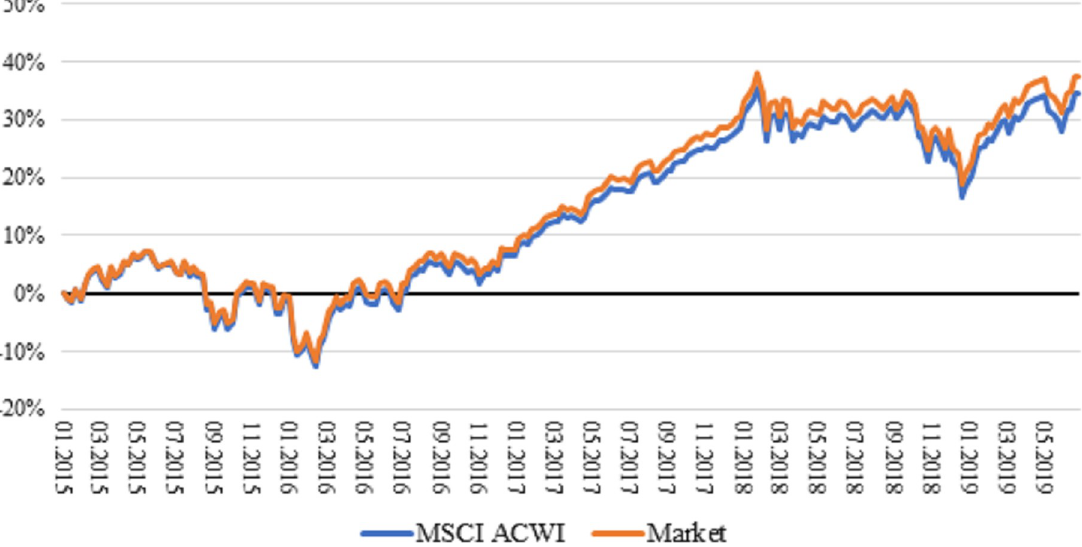
Fig 1. Cumulative total log return of MSCI ACWI Index and market portfolio. The market portfolio contains only companies that have prices, total returns and market capitalisations, and are not considered as penny stocks. “Market” portfolio is the reference point for the cross-sectional regressions. MSCI ACWI is the benchmark for the time series